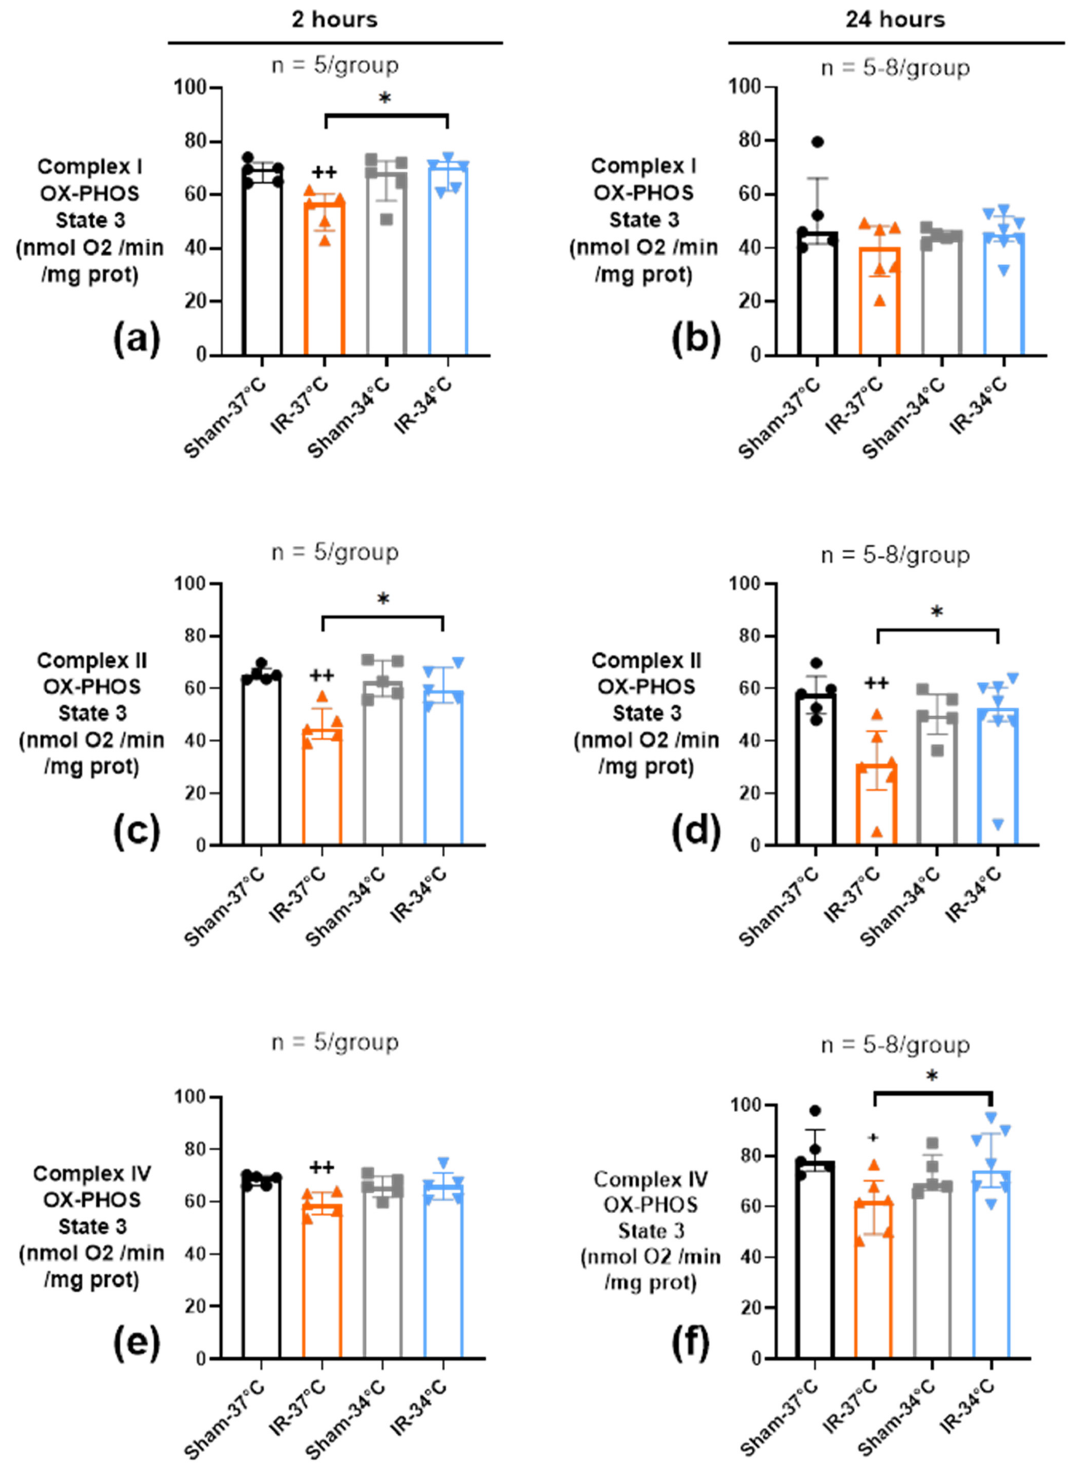
Figure 4. Oxidative phosphorylation (OX-PHOS) of kidney mitochondria after 20 min of bilateral renal ischemia where the mice body temperature was maintained at normothermia (IR-37 ◦ C) or at mild therapeutic hypothermia (mTH) (IR-34 ◦ C), and 2 h ( a , c , e ) or 24 h ( b , d , f ) of reperfusion, or after a Sham procedure with the same body temperature (Sham-37 ◦ C and Sham-34 ◦ C). Sensitive rates of OX-PHOS of electron transport chain (ETC) complex I, II, and IV were measured through O 2 consumption of 250 µ g kidney mitochondria. For each complex, state 3 represents the maximal